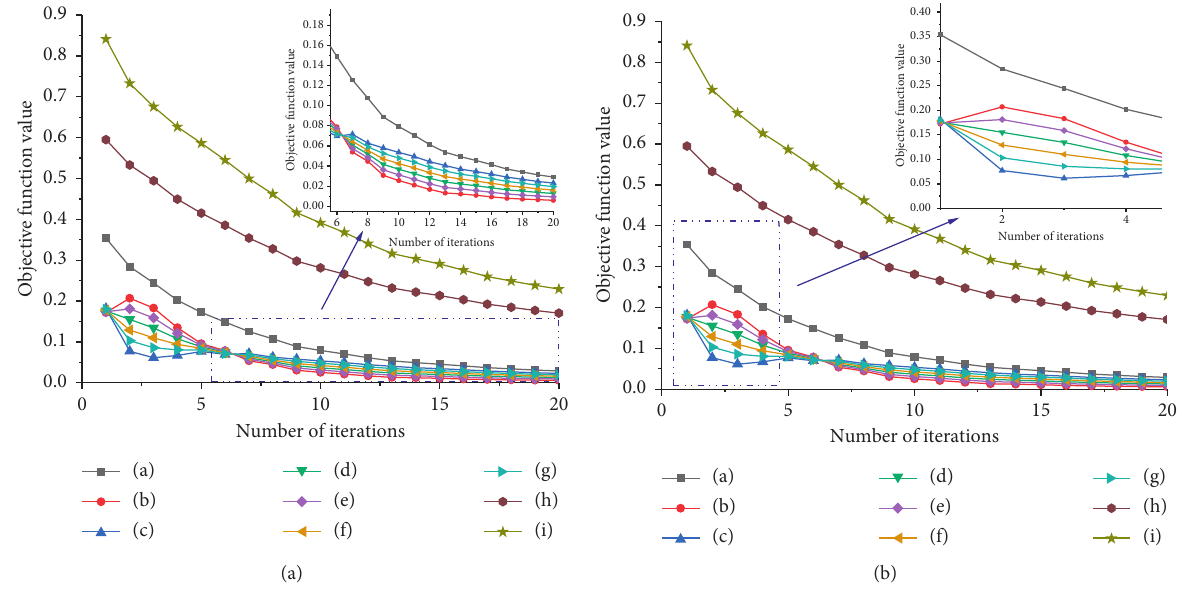
Figure 17: The convergence results of CSI with fixed weights for “ U -shaped” groove.